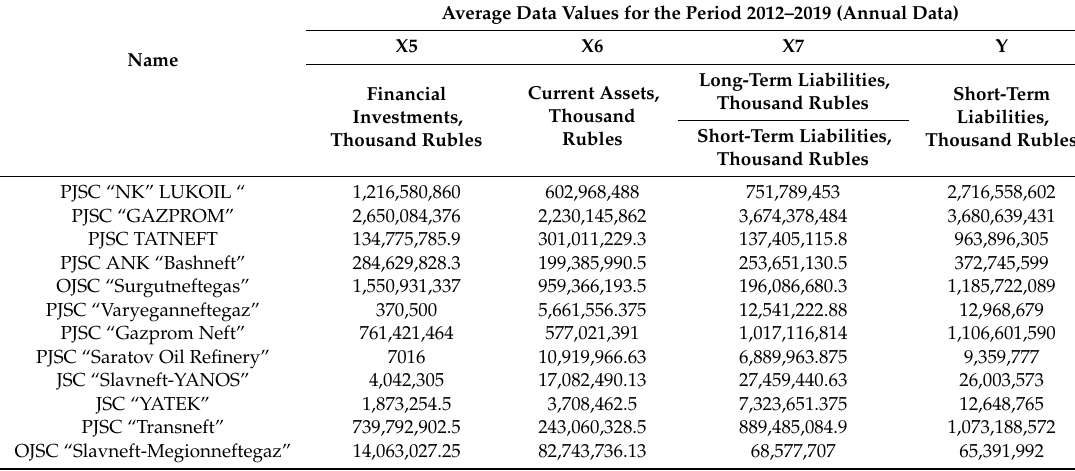
Table A2. Research results for the oil and gas industry (annual data, yearly data).